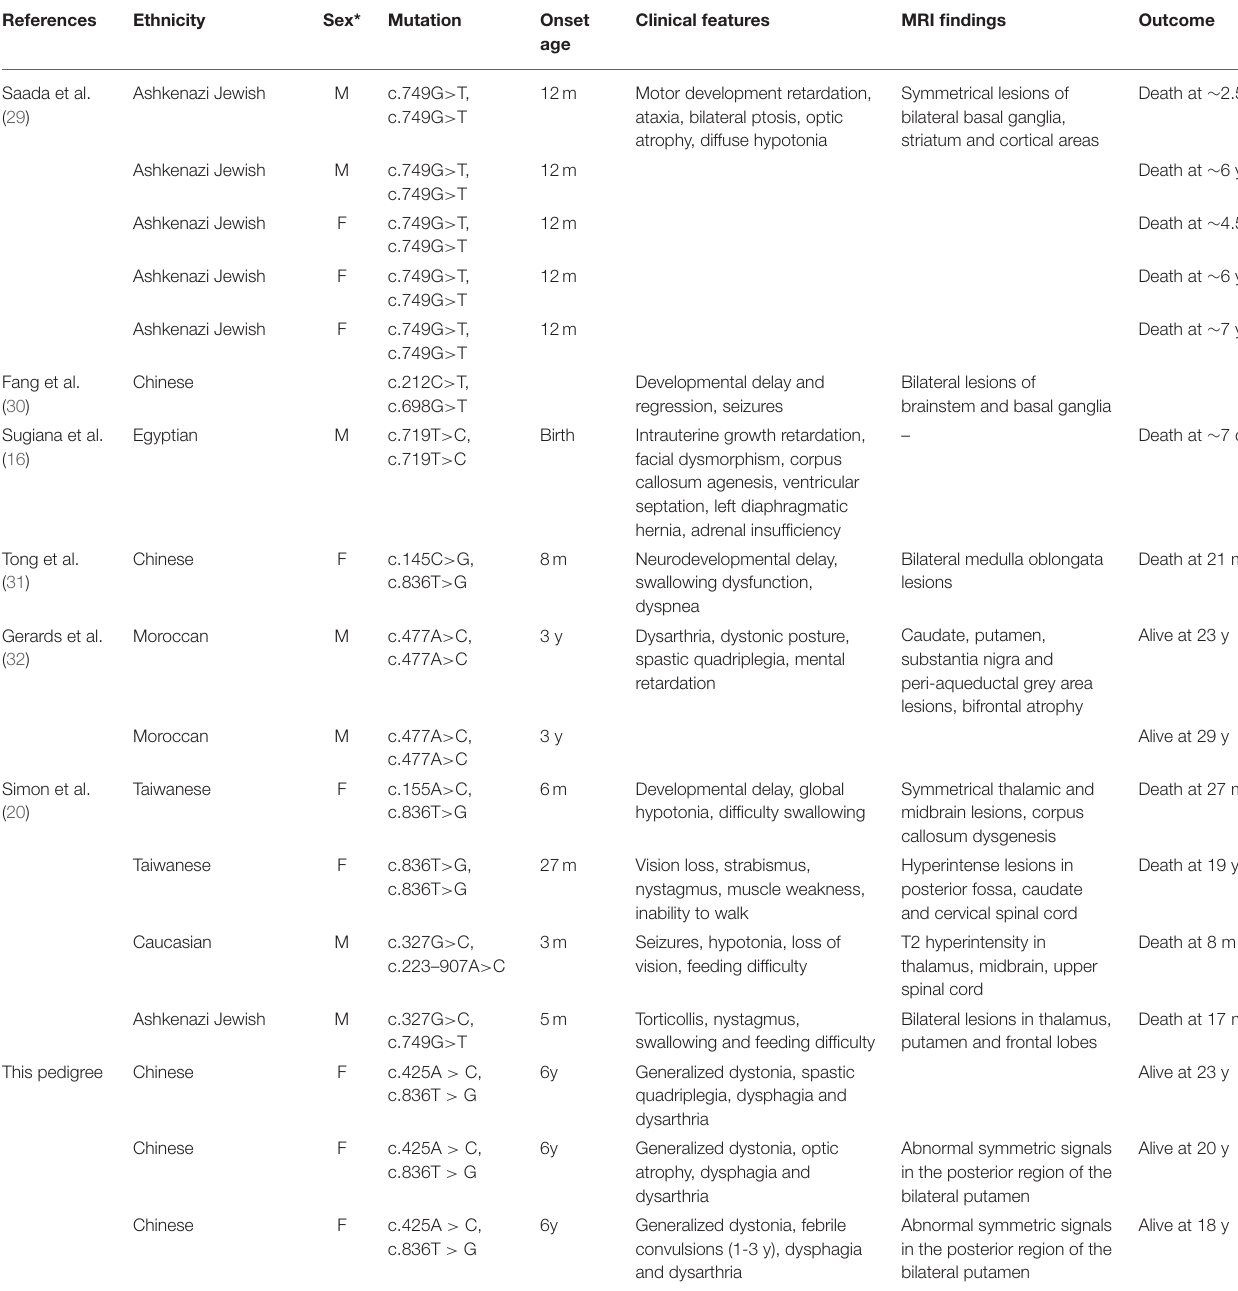
TABLE 1 | Clinical features of patients with NDUFAF5 variations reported in